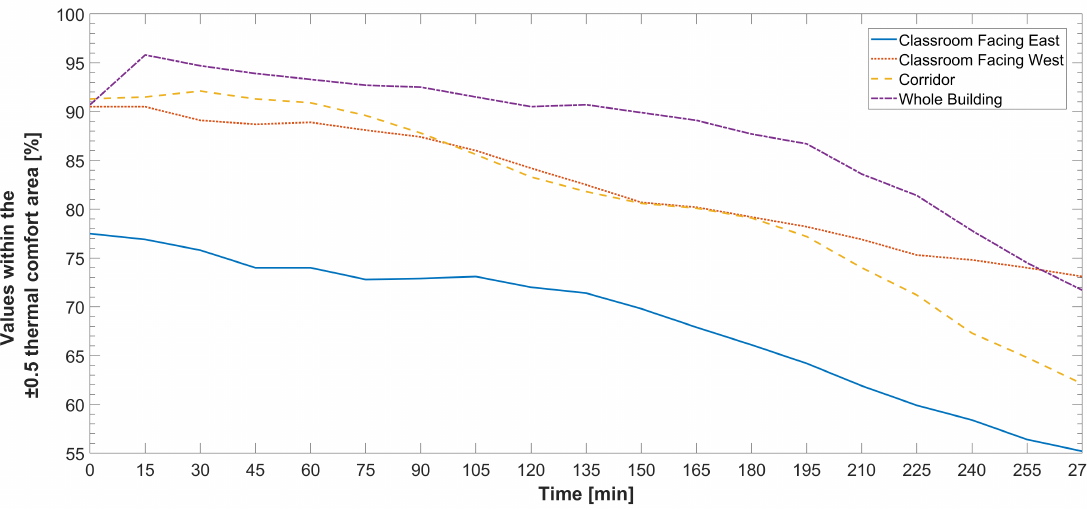
Figure 8. PMV/PPD evaluation graph on real